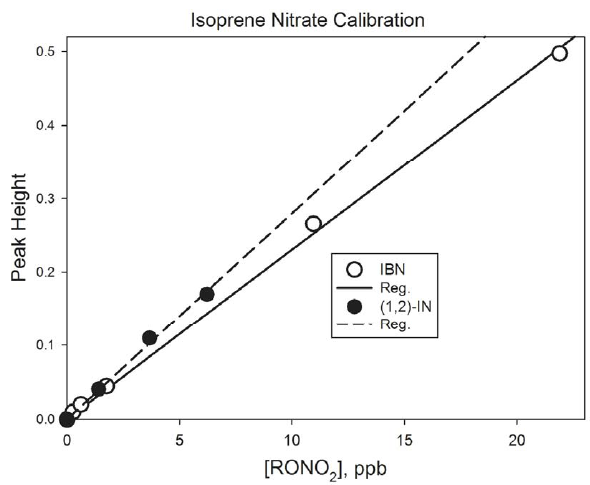
Fig. 4. Calibration curves for the (1,2)-IN and isobutyl nitrate.